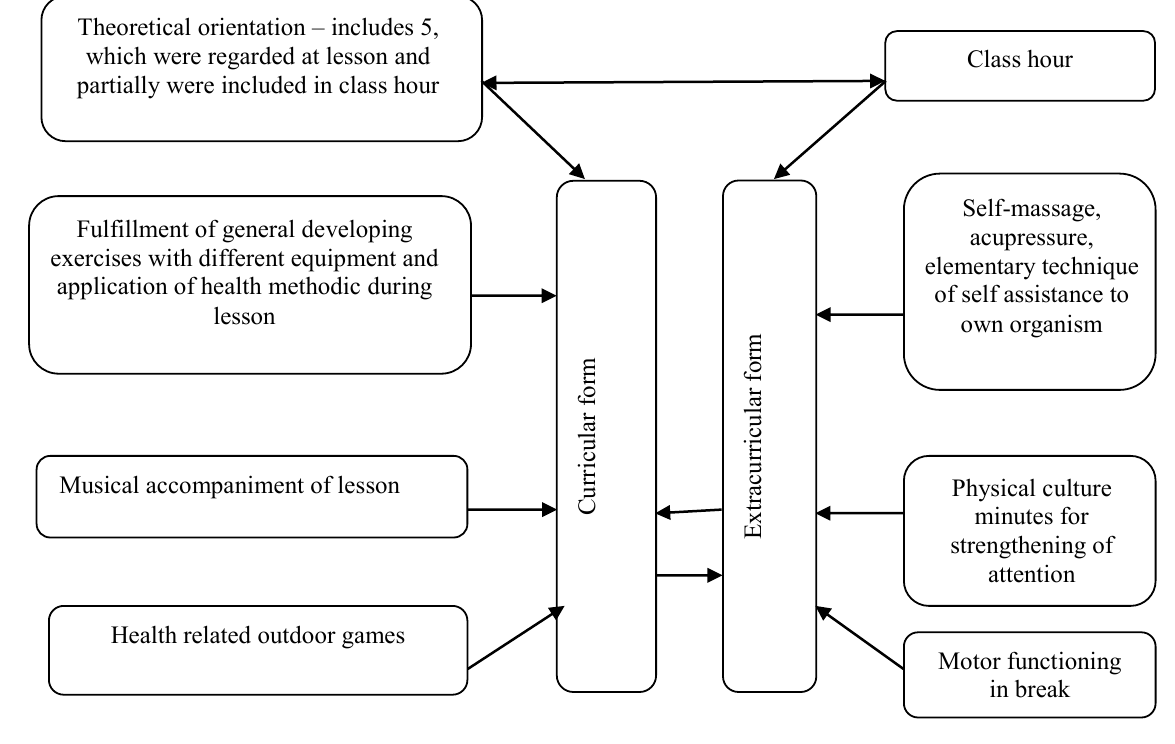
Fig.1. Diagram of experimental health related